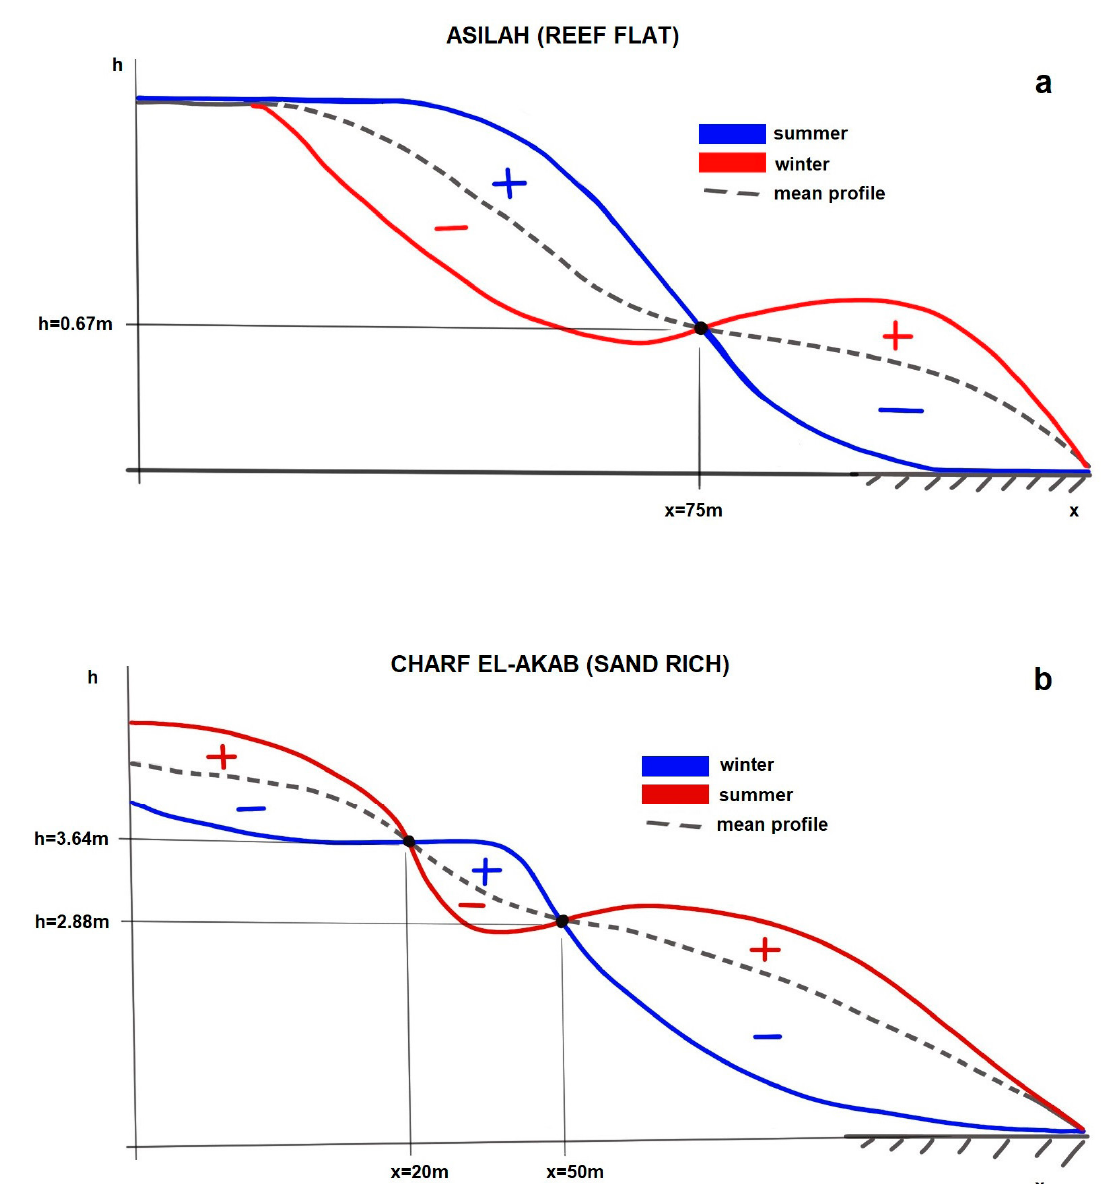
Figure 7. Sketch of seasonal changes in beach profiles at ( a ) Asilah and ( b ) Charf el-Akab